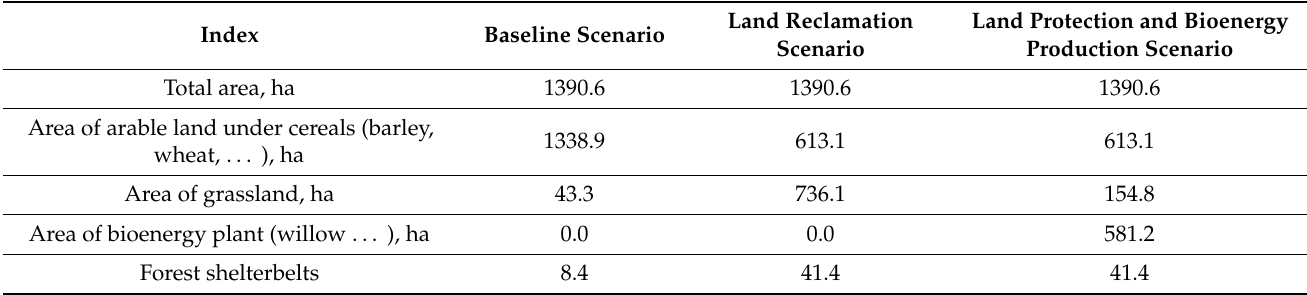
Table 2. Redistribution of the land area within ‘Promin-M’ farming enterprise territory referring to the approved land use scenarios.